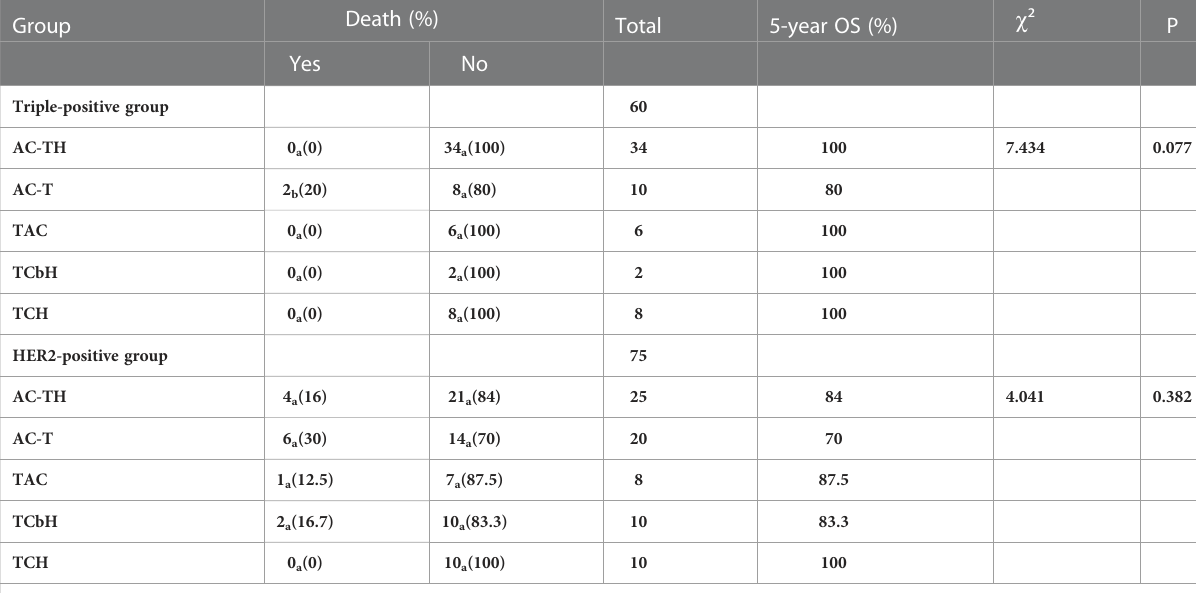
TABLE 6 Survival with different chemotherapy regimens in the triple-positive and HER2-positive groups. Group